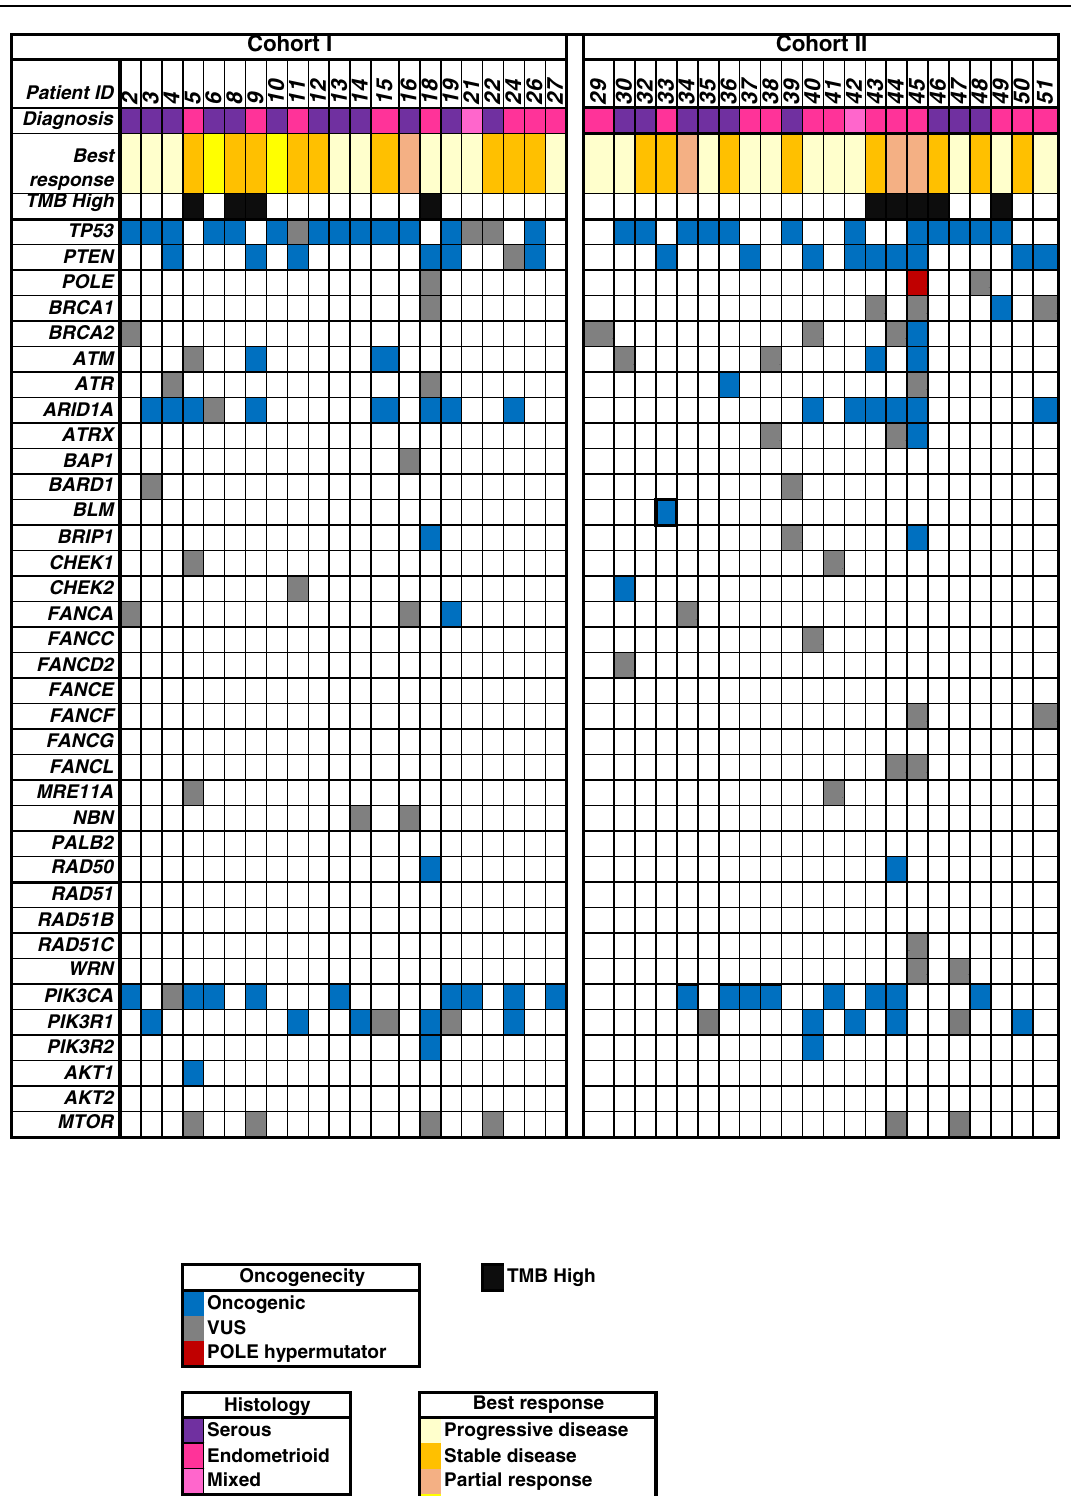
Fig. 3 | Oncoprint representing distribution of oncogenic and variants of uncertain signi fi cance (VUS) from archival tumour tissue. Cohort 1 with niraparib monotherapy ( n =21). Cohort 2 with niraparib and dostarlimab ( n =22).